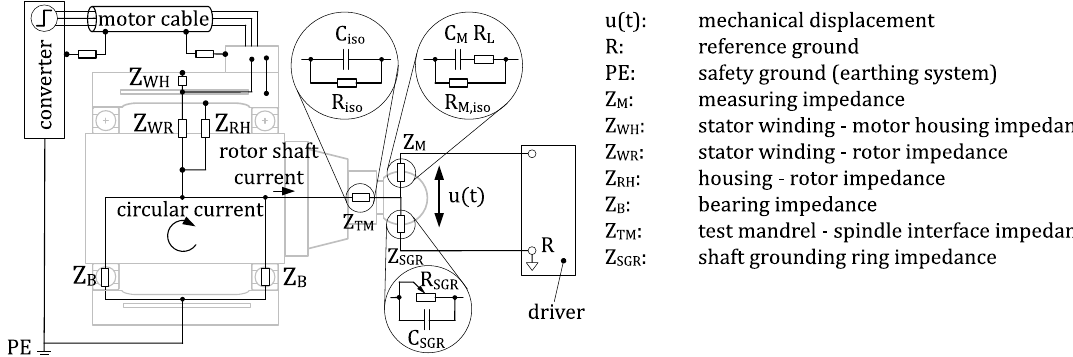
Figure 3. Schematic of interconnection between tool spindle and capacitive measurement